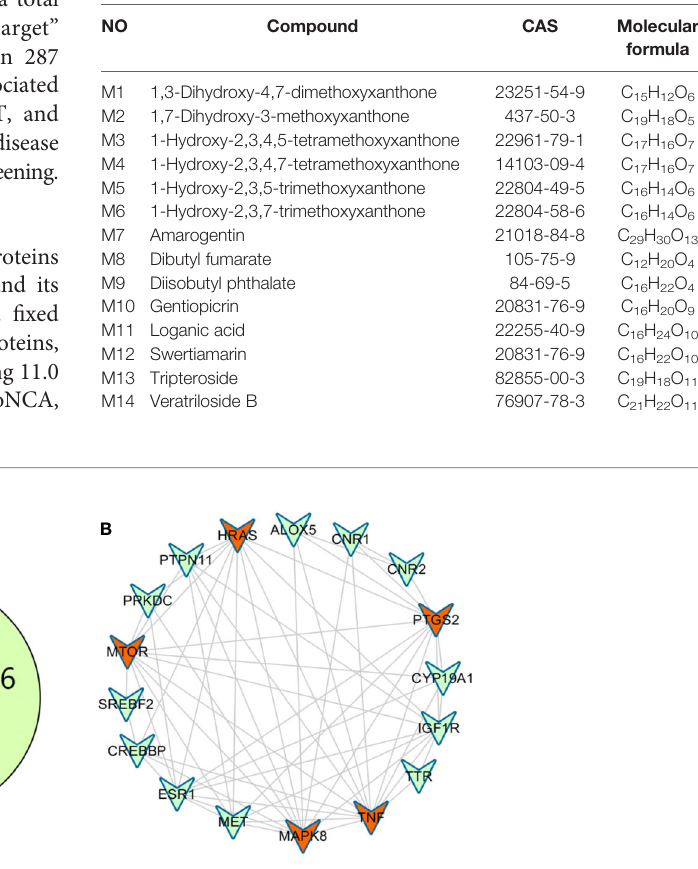
TABLE 3 | Information on 14 compounds of Veratrilla baillonii .